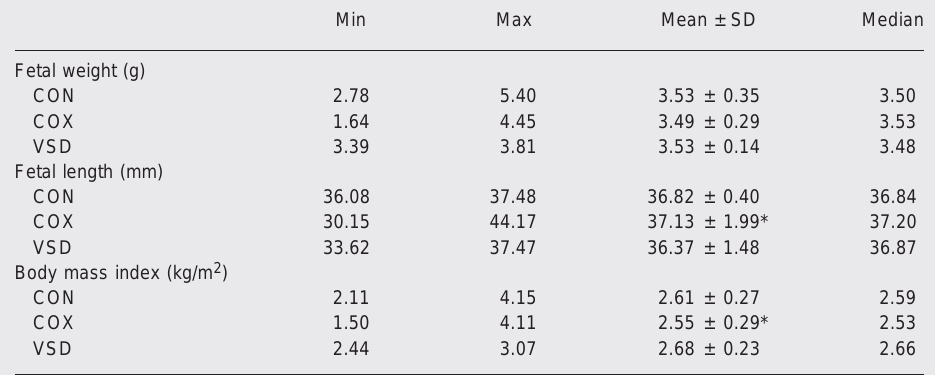
Table 2. Developmental parameters of untreated control rat fetuses (CON; N = 198), fetuses without any internal congenital malformations (COX; N = 1363) and offspring born with ventricular septal defects (VSD; N = 6) in groups prenatally exposed to various COX